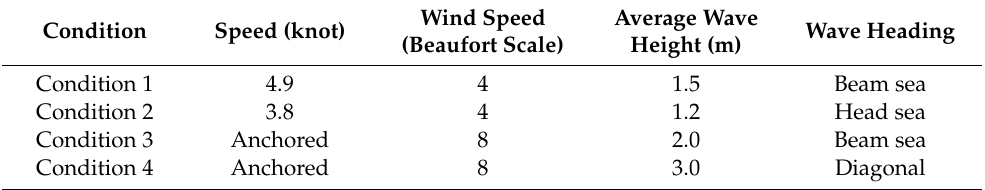
Table 2. Four typical